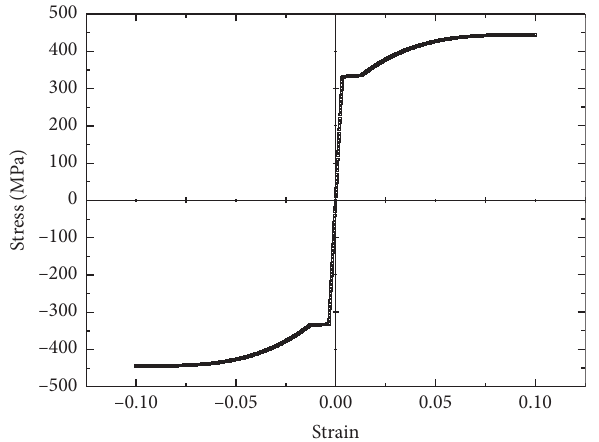
Figure 6: Stress-strain curve of steel in uniaxial stress state.